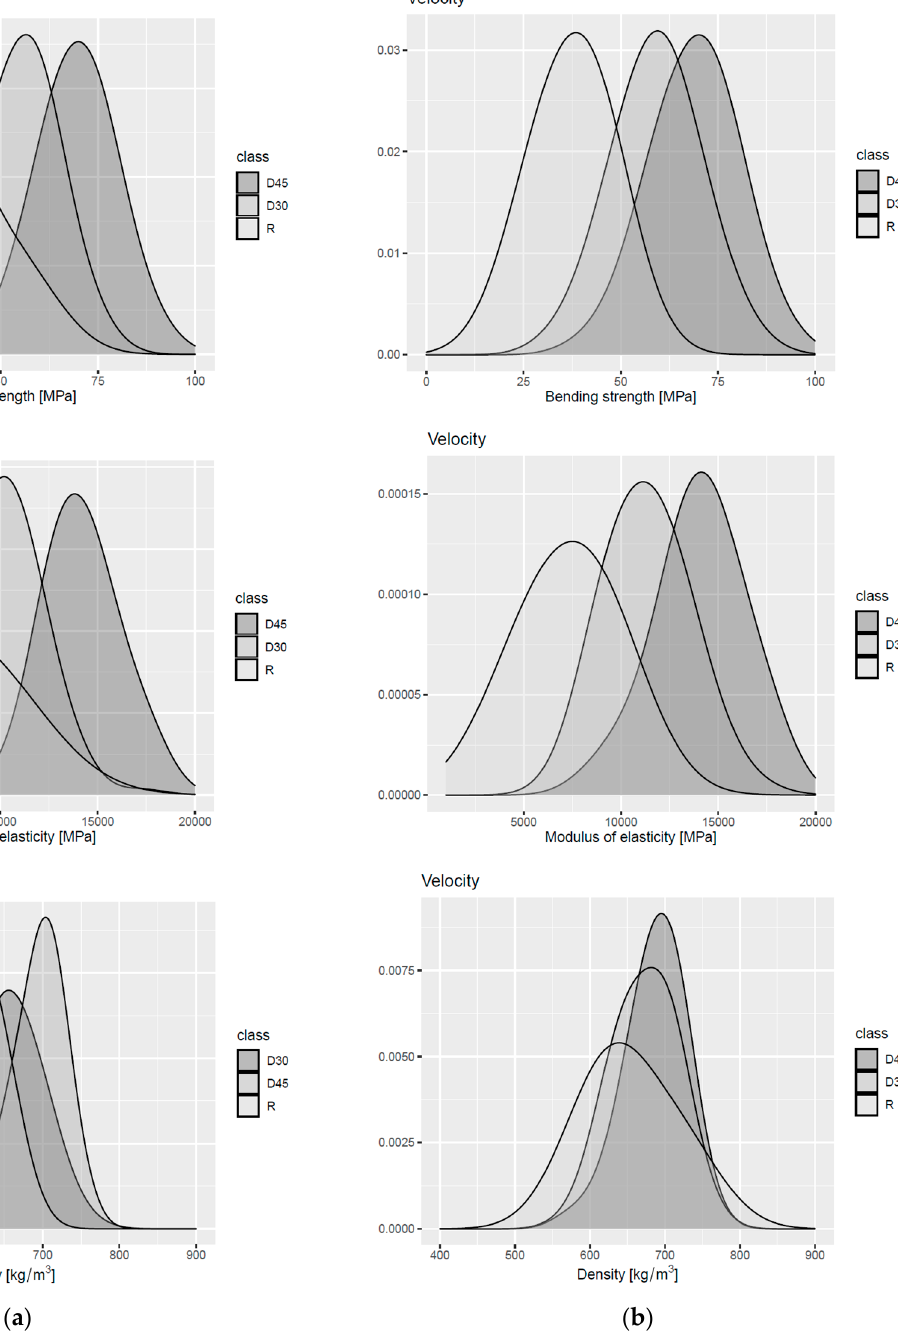
Figure 2. Density curves for bending strength, modulus of elasticity, and wood density of the three classes (D45-D30-R) sorted by the machine grading, by the dynamic modulus of elasticity ( a ) and the velocity ( b ).